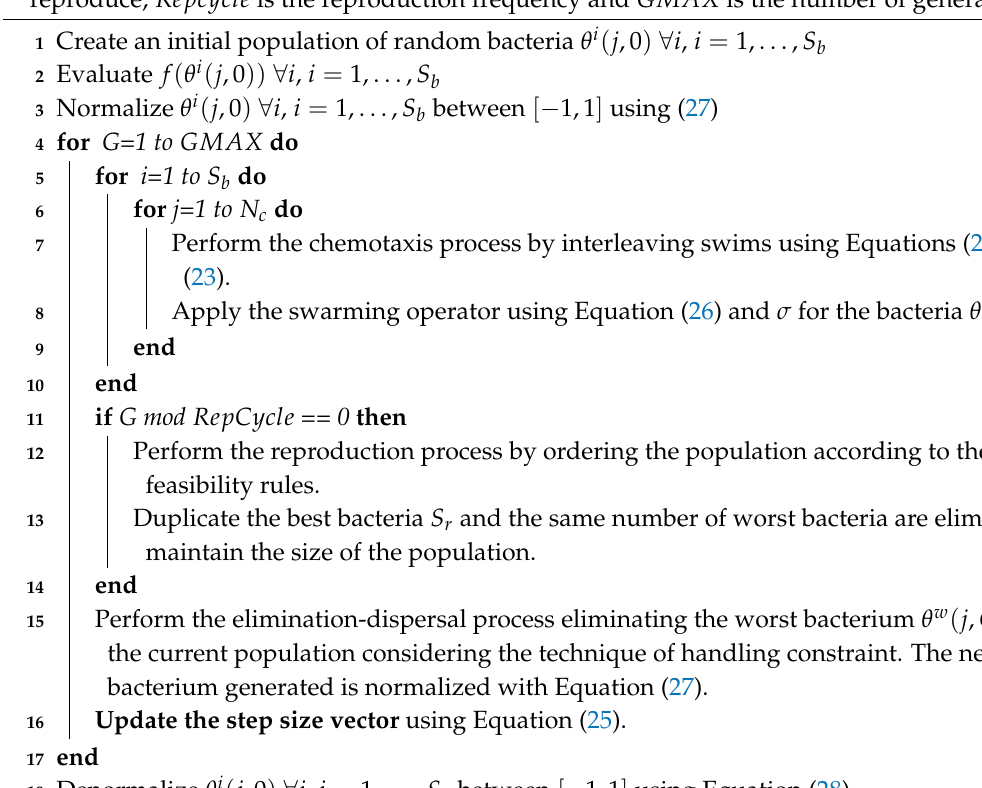
Algorithm 2: NTS-MBFOA pseudocode. S b is the number of bacteria, N c is the number of chemotaxis cycles, σ is the scaling factor, R is the step size, S r is the number of bacteria to reproduce, Repcycle is the reproduction frequency and GMAX is the number of